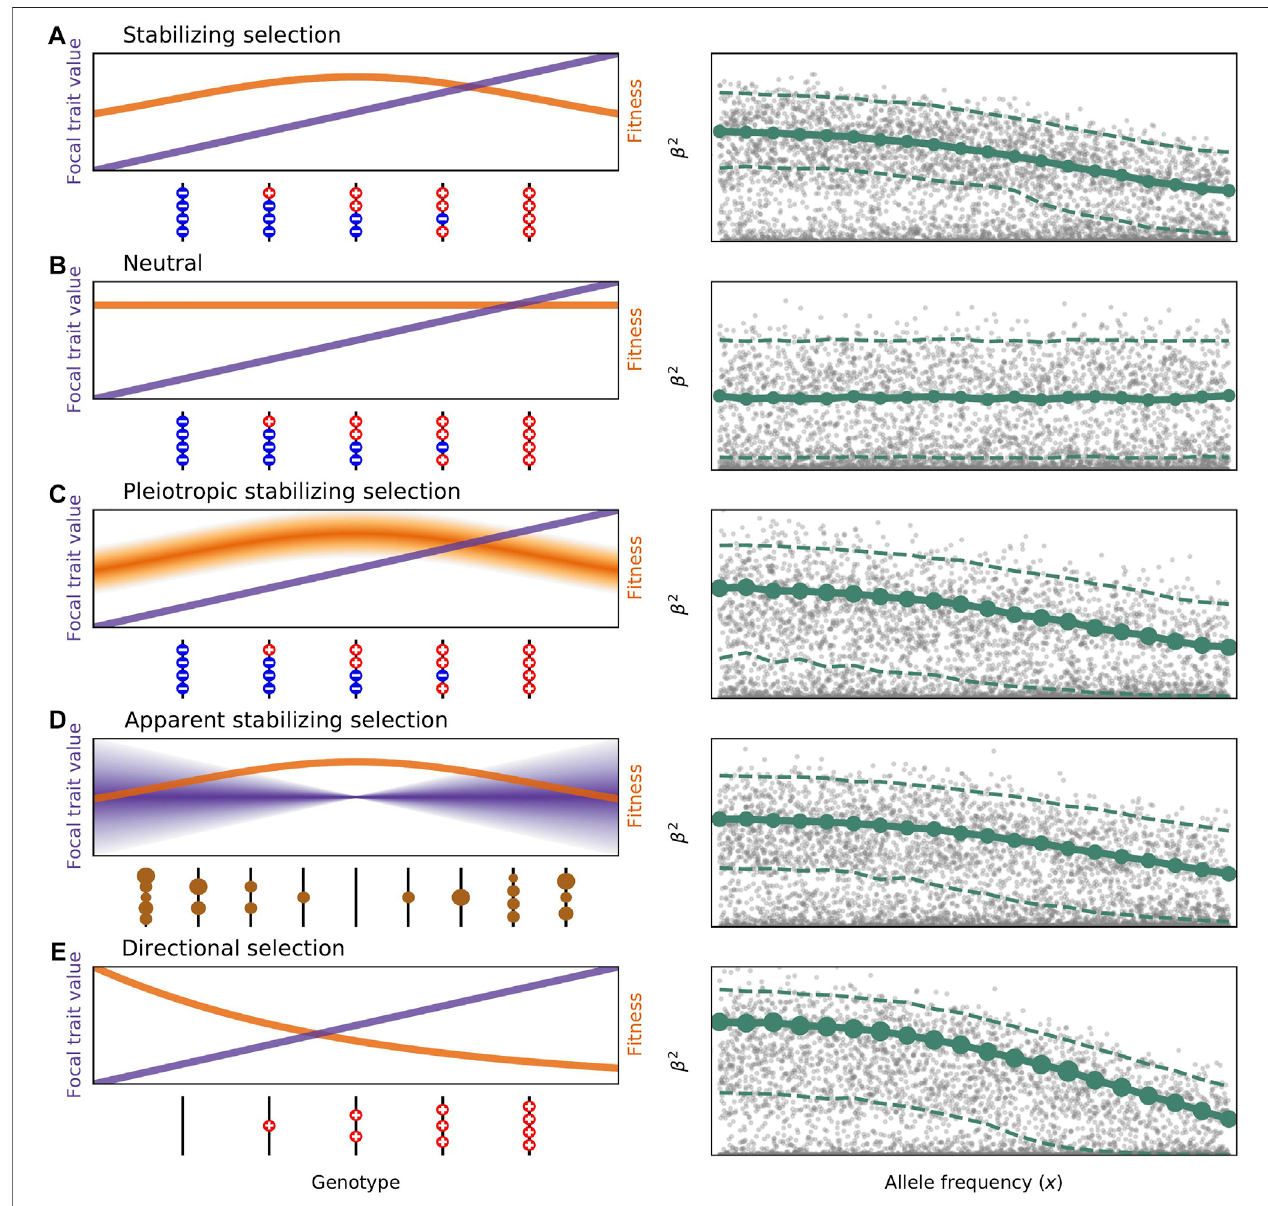
FIGURE1| Modelsofselectiononthegeneticvariationin fl uencingcomplextraits.Panelsontheleftshowhowdifferentgenotypesaffecttraitvalues(inpurple)and fi tness(inorange).Panelsontherightillustratehowsquaredtraitvalueschangewithfrequencyineachmodelofselection.Simulated valuesareshowningrey,themean E [ β 2 | x ]isrepresentedbythesolidgreenline,and thestandard deviation of β 2 | x isrepresented bythesizeofthegreen circles. Themedian and 97.5 % quantile areshown as dashed lines to give a better sense of the full leptokurtic distribution of effect sizes. The DFE used in all plots (shape (cid:1) 0.25, scale (cid:1) 40) was chosen to be within the range fi t by Schoech et al. (2019). Effect sizes were simulated uniformly on log frequency, and both axes are on a log scale. (A) Classic stabilizing selection as describedby Eq.1 .Genotypes containingmoretrait-increasing alleles thandecreasing, andviceversa, havelower fi tnessasaresultofselectiononthefocaltrait.Large effect alleles are prevented from reaching high frequencies due to the variance-reducing property of stabilizing selection. (B) In the neutral model no genotype is more fi t than any other and the distribution of effect sizes at any frequency re fl ects only the distribution of mutational effects. (C) In pleiotropic stabilizing selection as studied bySimonsetal.(2018),thereisvariationin fi tnessforeachgenotypicvaluesdependingontheeffectsmutationshaveonpleiotropictraits.Thisleadstothesameaverage E [ β 2 | x ] but a greater variance and therefore different genetic architecture. (D) Models of apparent stabilizing selection fi rst specify the deleterious fi tness effects of mutations, represented here bythe sizeofthe brown circles. Genotypes withmore and stronger deleteriousmutations have agreater variance in phenotypic outcomes. This too leads to a negative relationship between β 2 and x . Here we use the Eyre-Walker (2010) model with τ (cid:1) 0.4 as fi t by Schoech et al. (2019), and σ 2 (cid:1) 1. Altering thesewouldchangethemeanandvarianceofthe( β 2 , x )relationship. (E) Directionalselectionisshownhereforascenariowheretrait-decreasingmutationsareunlikelyor impossible. Selection therefore acts to reduce the frequency of trait-increasing alleles. All new mutations are disfavored with s ∝ β . E [ β 2 | x ] again decreases with x .